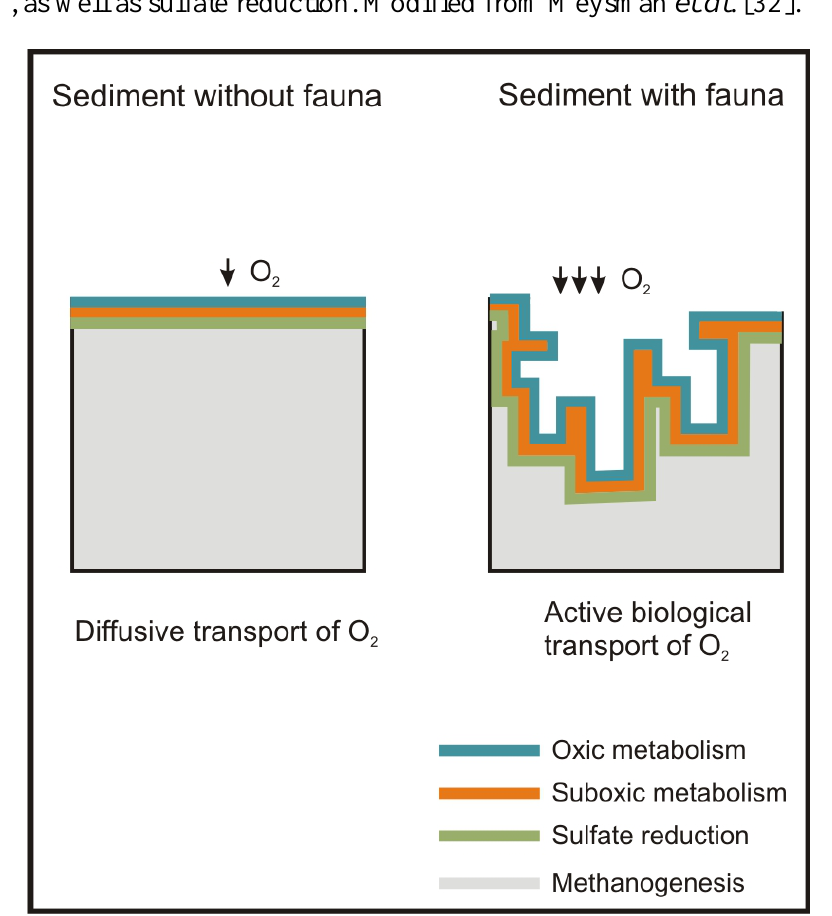
Figure 1. Effect of active biological transport on the sediment promoting oxic and suboxic metabolism, as well as sulfate reduction. Modified from Meysman et al .